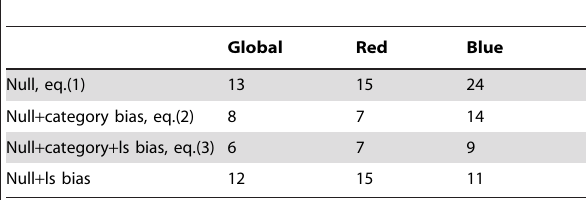
Table 1. The number of mismatches produced by different models (equations (1), (2), and (3), as well as the null model and lightness-saturation bias) for the global, red, and blue conditions.